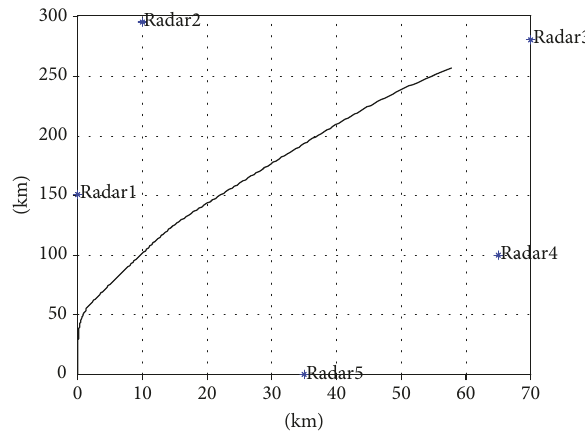
Figure 1: Target trajectory.